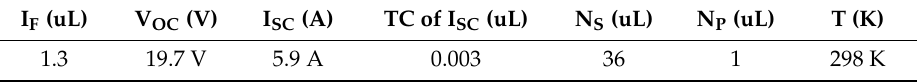
Table 1. Functional block parameters of the SM-85KSM PV module.